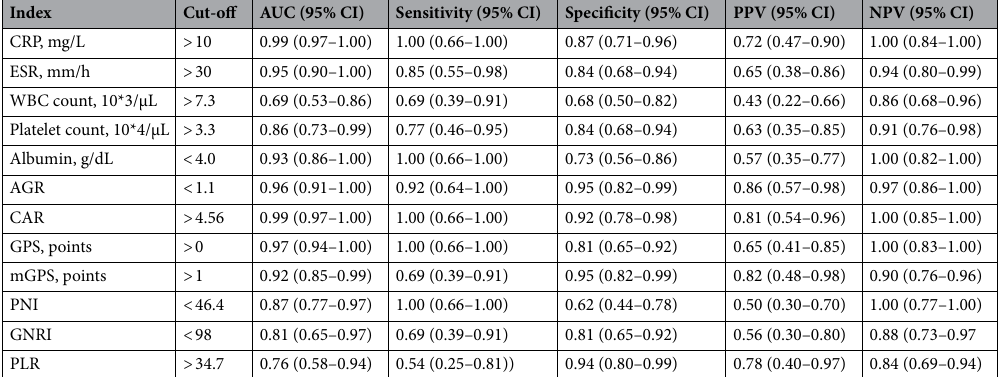
Table 7. Diagnostic accuracy of the markers of infection. AGR Albumin/globulin ratio, AUC Area under the curve, CAR CRP-albumin ratio, CI Confidence interval, CRP C-reactive protein, ESR Erythrocyte sedimentation rate, GNRI Geriatric nutritional risk index, GPS Glasgow prognostic score, mGPS Modified Glasgow prognostic score, NPV Negative predictive value, PLR Platelet/lymphocyte ratio, PNI Prognostic nutrition index, PPV Positive predictive value, WBC White blood